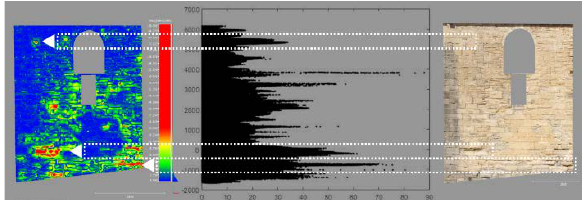
Figure 22. Graph of the distribution of roughness along the z- axis.